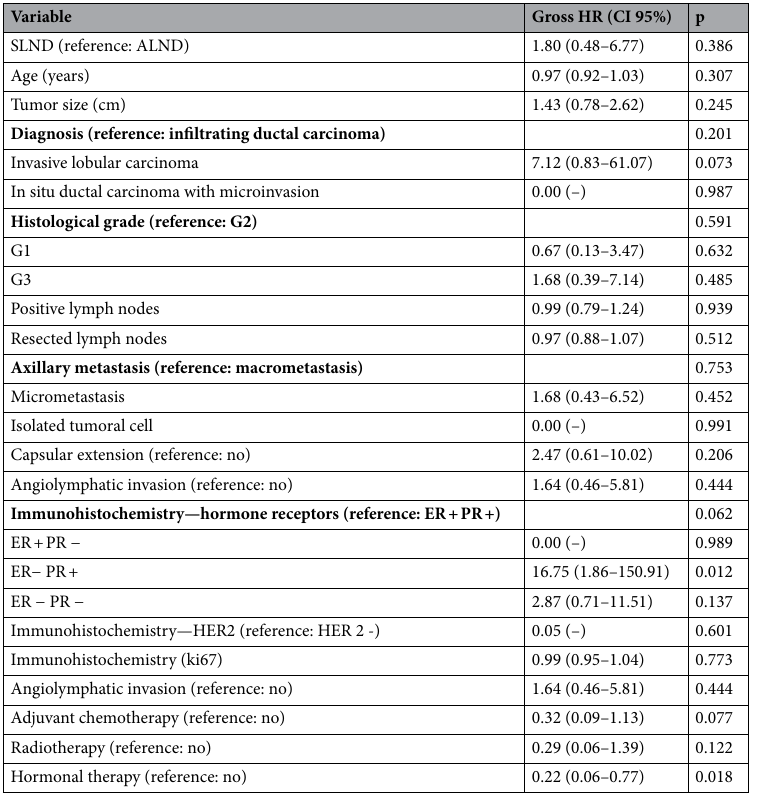
Table 3. Survival analysis using Cox univariate regression in patients undergoing ALND or SLND alone. (−) not shown due to lack of precision. HR hazard ratio, Tis ductal carcinoma in situ, T1 tumor size, T2 tumor size 20–50 mm, N0i + the area of cancer spread contains fewer than 200 isolated tumor cells and is smaller than 0.2 mm (cancer cells seen in routine stains or immunohistochemistry), N1mi micrometastasis to lymph